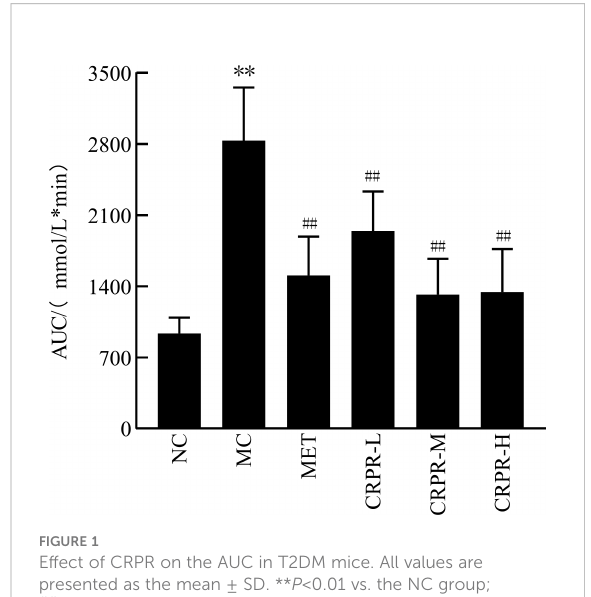
FIGURE 1 Effect of CRPR on the AUC in T2DM mice. All values are presented as the mean ± SD. ** P <0.01 vs. the NC group; ## P <0.01 vs. the MC